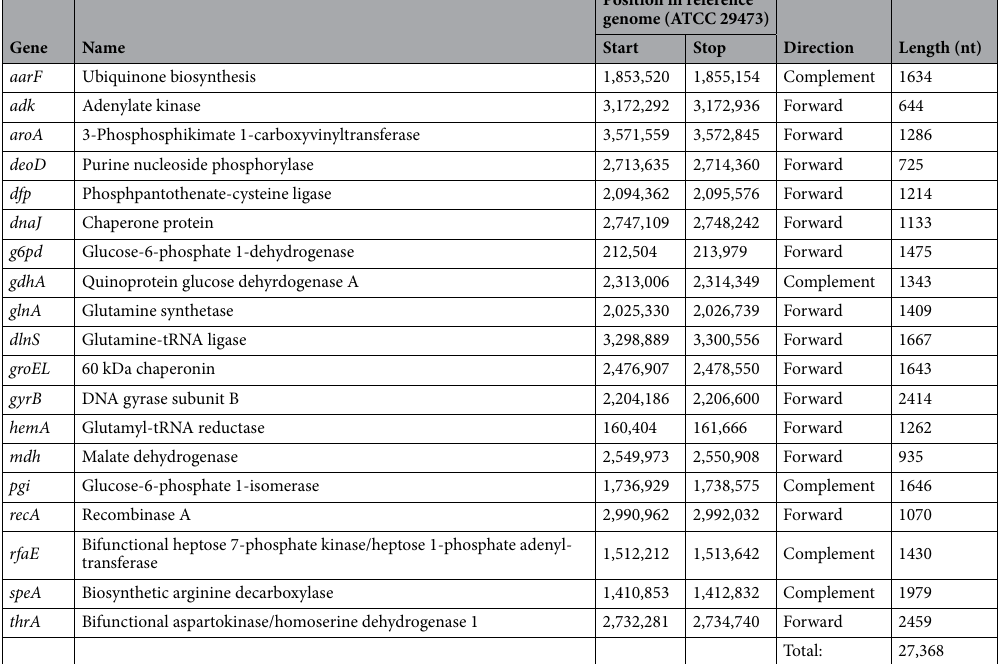
Table 2. Housekeeping genes included in phylogenetic study of Yersinia